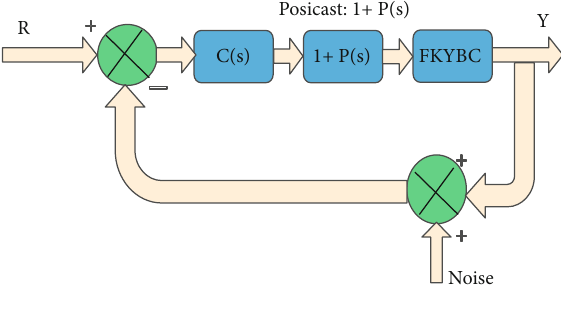
Figure 5: FKYBC with HPC.